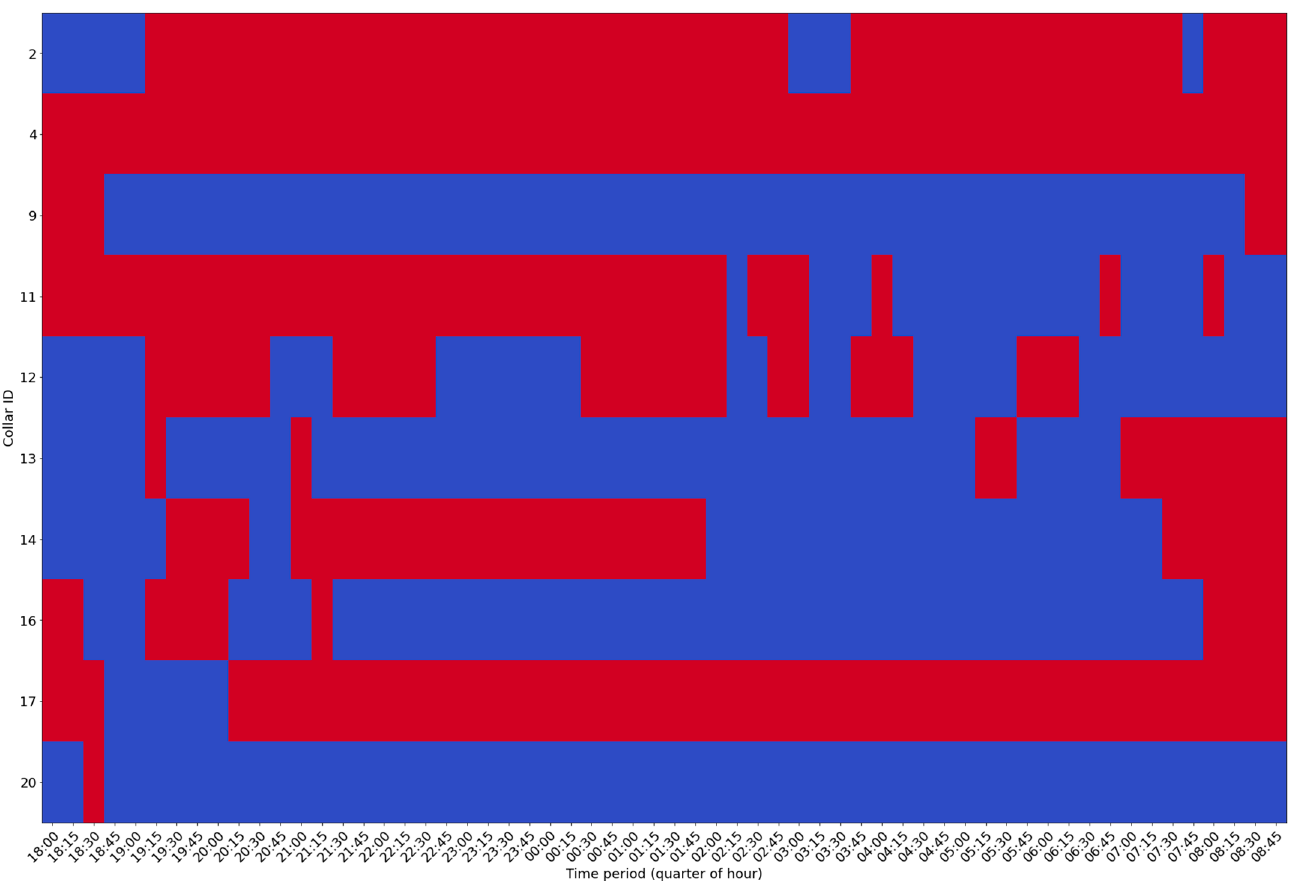
Figure 4. Activity classification between 18:00 05/12 and 9:00 06/12 in 15m intervals. Red blocks represent active periods and blue blocks represent inactive periods.